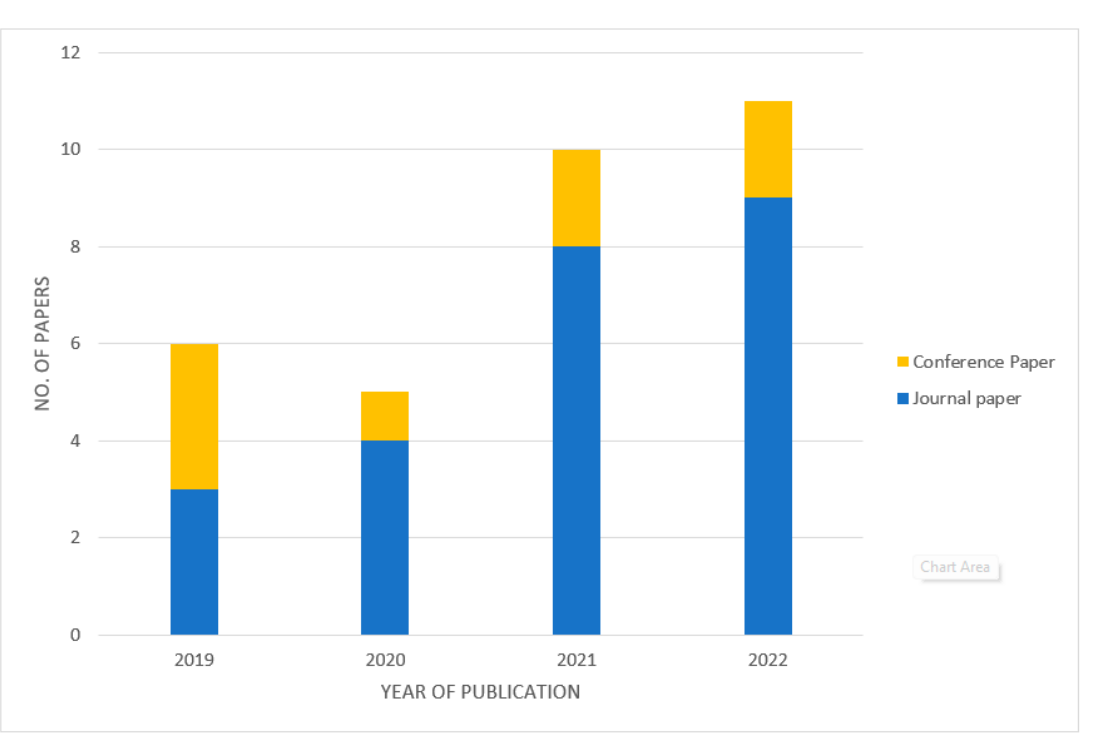
Figure 2. Global yearly publications on digital twins for energy efficiency.